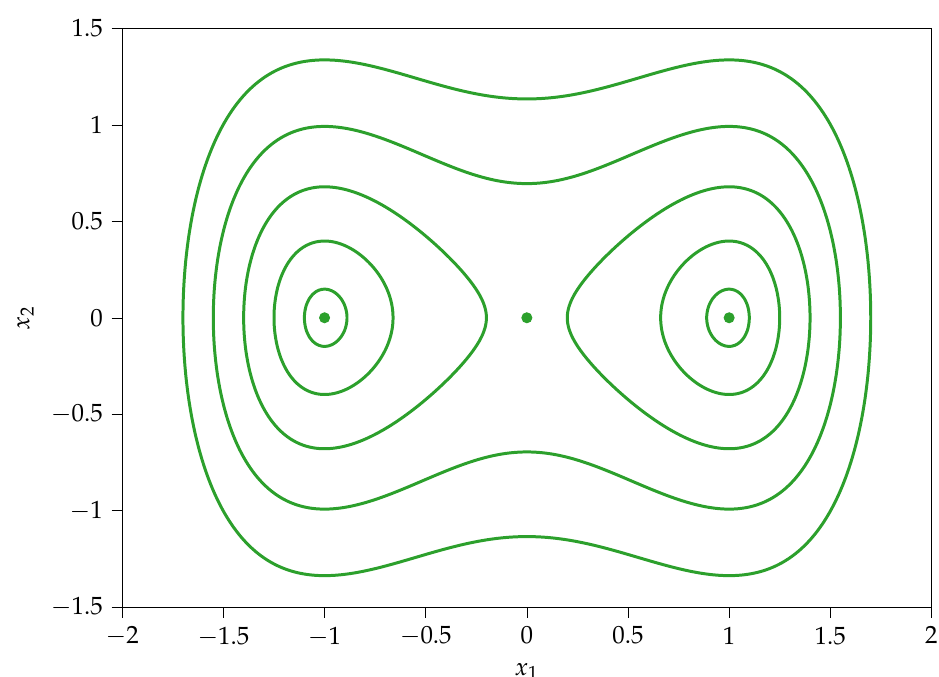
Figure 1. Phase plot of the undamped Duffing oscillator. The equilibria are makes as